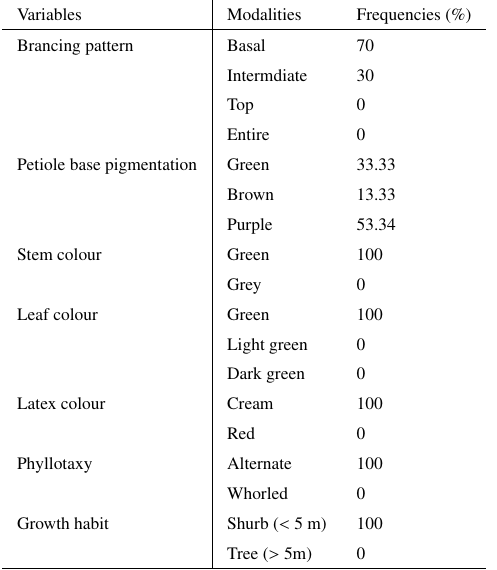
Table 2. Variation in the qualitative characters of the collection of J. curcas .